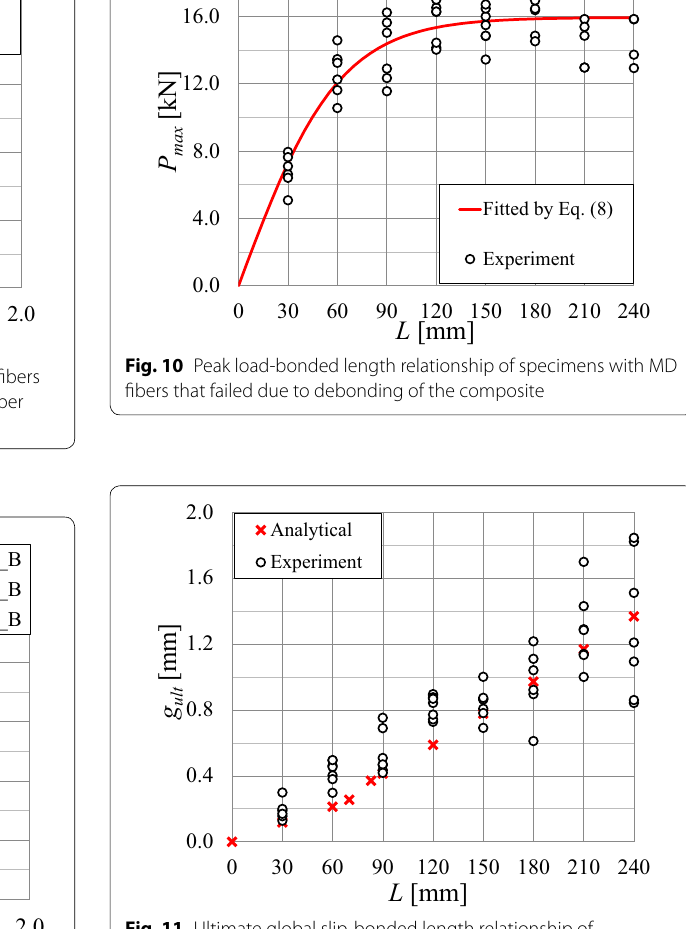
Fig. 11 Ultimate global slip-bonded length relationship of specimens with MD fibers that failed due to debonding of